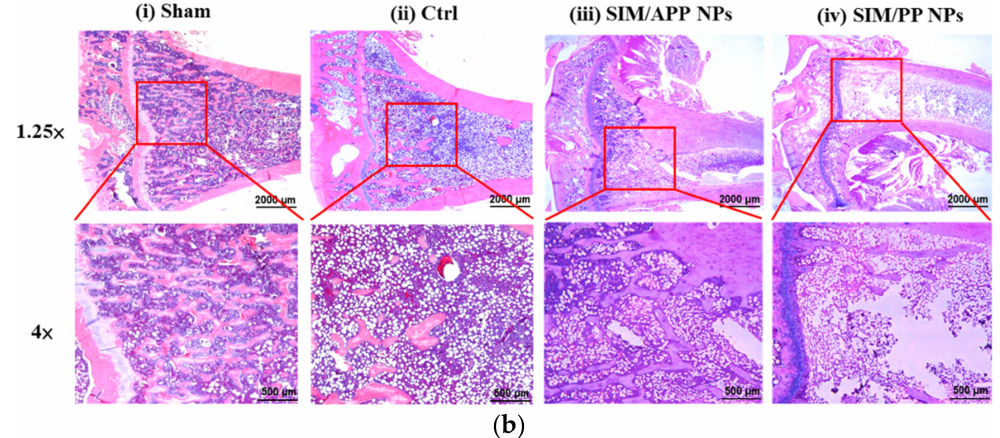
Figure 7. The bone formation effectiveness of SIM nanocarriers in postmenopausal osteoporosis SD rat models after OVX for 3 months. There were the following four groups: ( i ) sham group: no OVX surgery and no SIM drug treatment; ( ii ) control (Ctrl) group: OVX surgery and no SIM treatment; ( iii ) SIM/APP NP group: OVX surgery and SIM/APP NP treatment; and ( iv ) SIM/PP NP group: OVX surgery and SIM/PP NP treatment. Micro-CT was used to analyze the distal portion of the tibia bone, and the bone volume to total volume (BV/TV) ratio results represent the means ± standard deviation ( n = 3) ( a ). H&E staining also revealed the distal portion of the tibia bone tissue histologic sections ( b